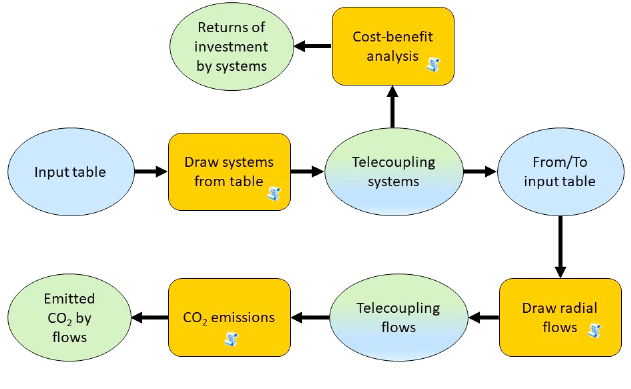
Fig. 3 . Flowchart showing an example of how separate geoprocessing tools contained in the Telecoupling Toolbox (orange boxes) can be interconnected and linked together. The example analysis workflow involves mapping telecoupling systems and flows, and calculating CO emissions for each 2 mapped flow and returns of investment for each telecoupling system. Inputs are represented as oval cyan-shaded boxes, outputs are shown as oval green-shaded boxes, and mixed cyan- green shades represent outputs that can be also used as inputs for a different